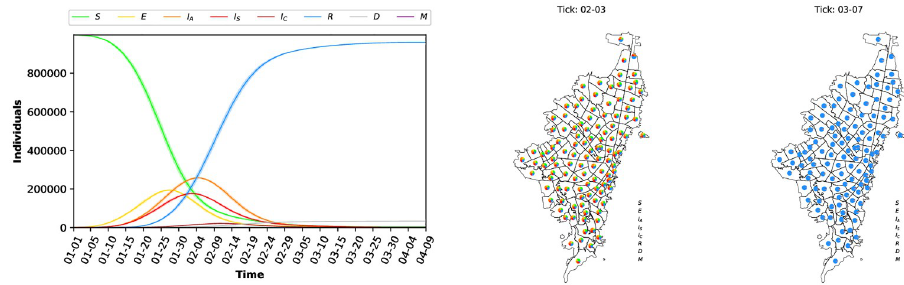
Fig 4. Evolution of the epidemic dynamics of INFEKTA. Full dynamics over time (left), and dynamics for each UPZ at specific time (right).